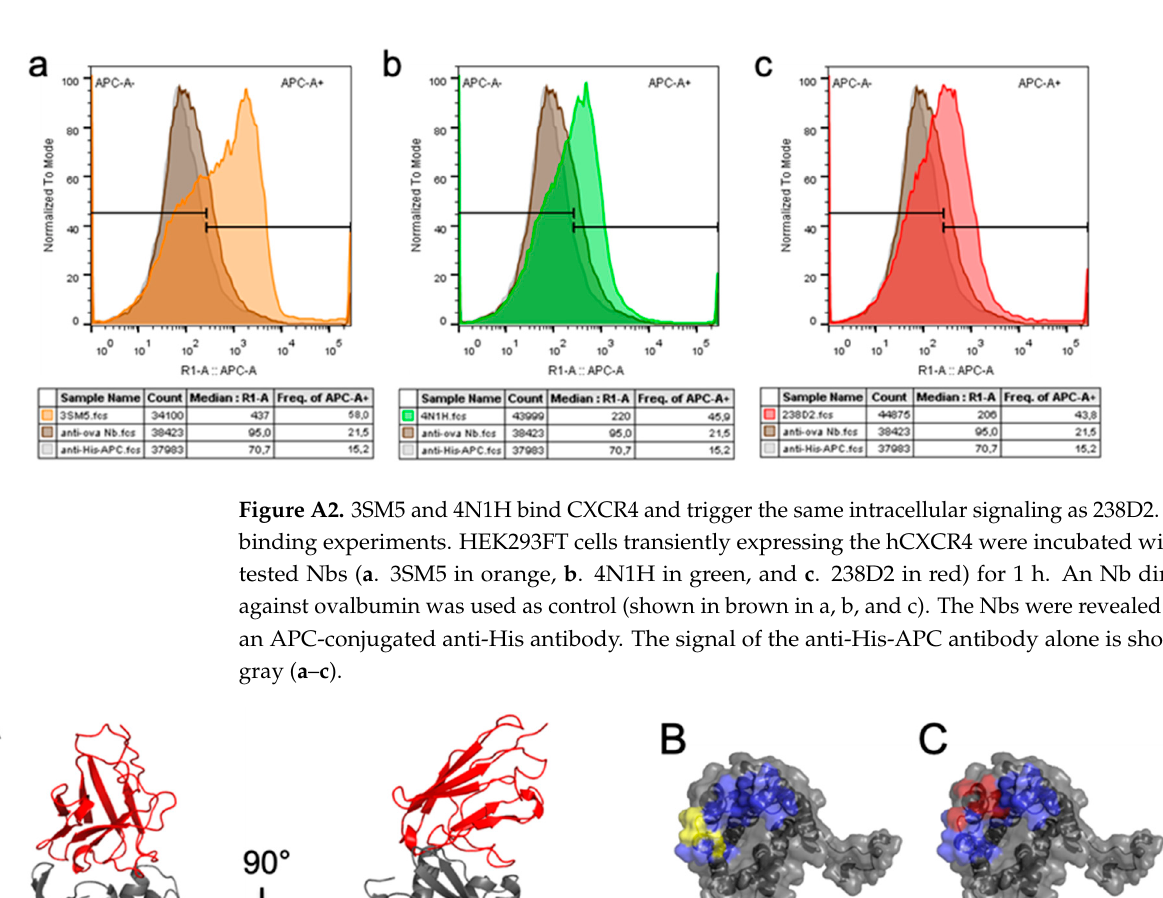
on the full-length sequence and for each of the three CDRs.